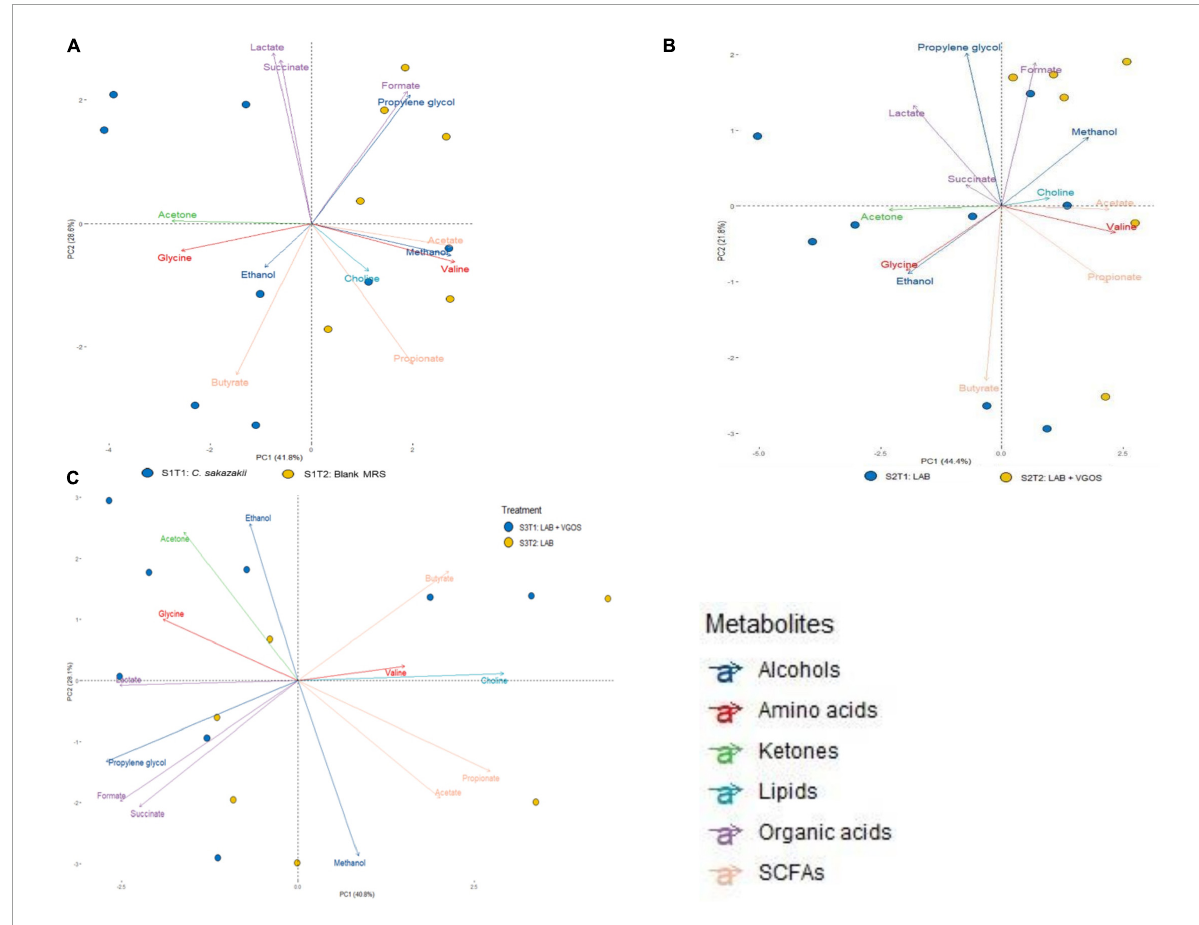
FIGURE3 Principal Component Analysis (PCA) biplot of metabolite profiles from SHIME 1 (A) , SHIME 2 (B) , and SHIME 3 (C) over a 2-week treatment period. Each sample (bubble) represents a different day during the treatment period. The 2-week treatment period is separated with approximately 1 week for each treatment period and labeled accordingly based on color (i.e., blue for the first treatment period and yellow for the second). MRS represents de Man, Rogosa and Sharpe media, LAB represents lactic acid bacteria, VGOS represents Vivinal GOS, and SCFA represents short-chain fatty acids. Arrows represent the different metabolites profiled and colored based on the type of